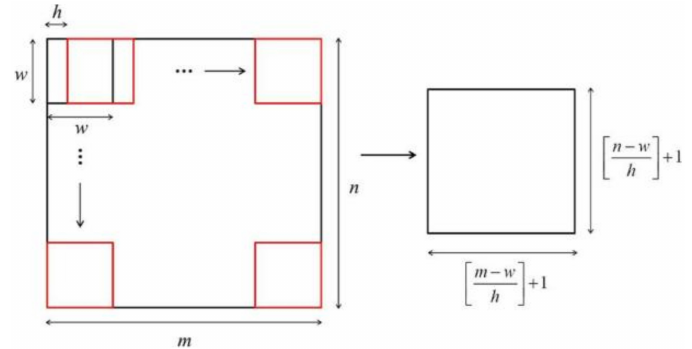
Figure 4. Variance matrix